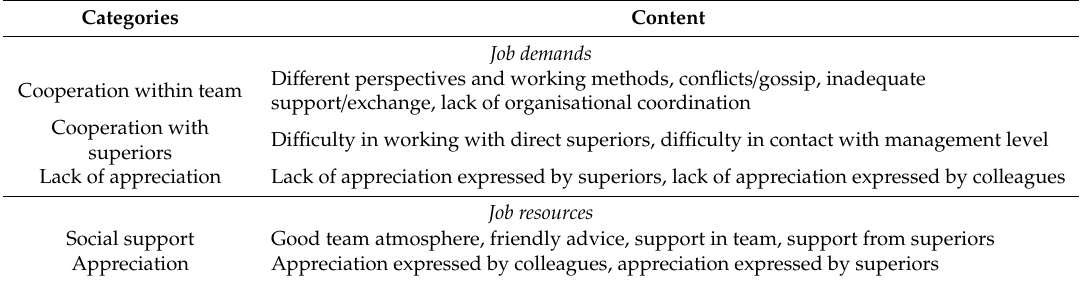
Table 4. Job demands and resources relating to social